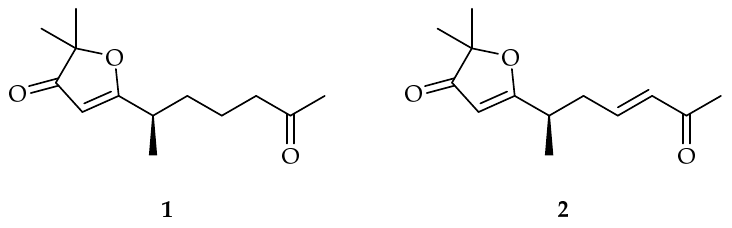
Figure 1. Structure of nornemoralisins A 1 [5] and B 2 [5].